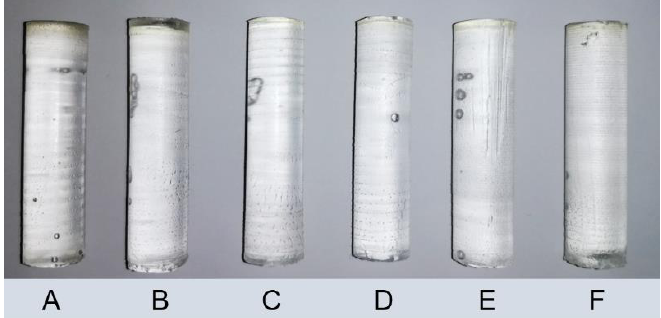
Figure 9. Depth cure of PBS A – F, and resulting specimens (height 52 mm, diameter 10 mm).